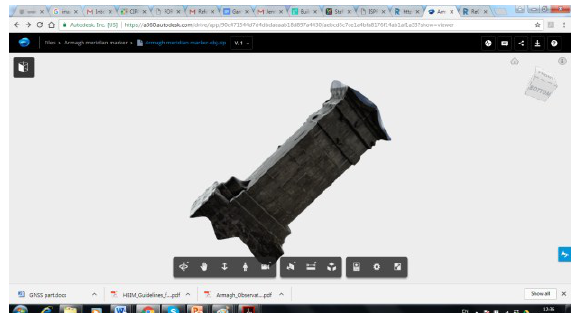
Figure 9: Photogrammetric Virtual Reconstruction of